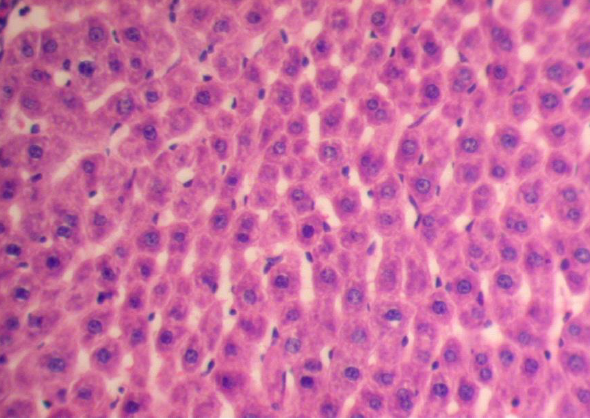
Fig. 1. Liver of an intact rat. Normal state of the liver parenchyma. Hematoxylin-eosin. ×250